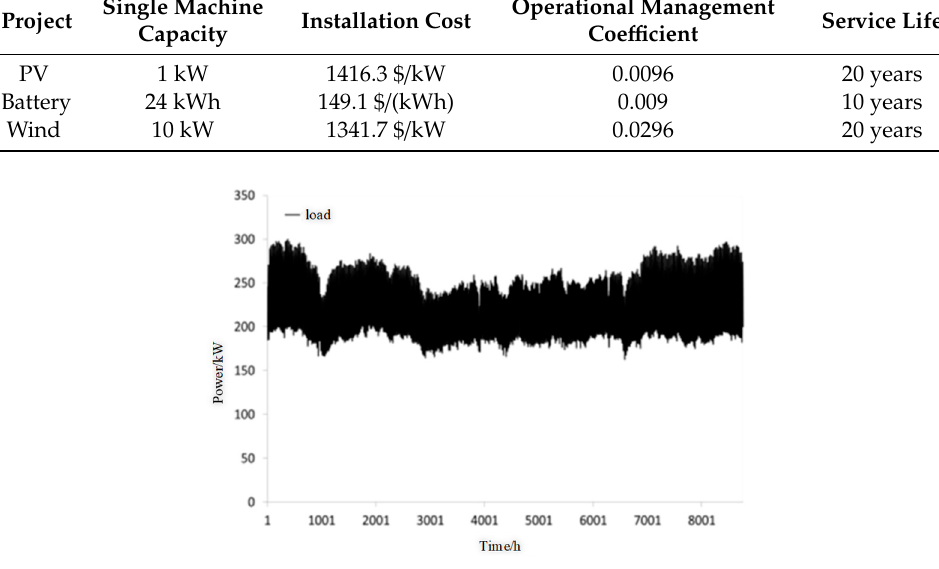
Table 1. Distributed energy parameters.